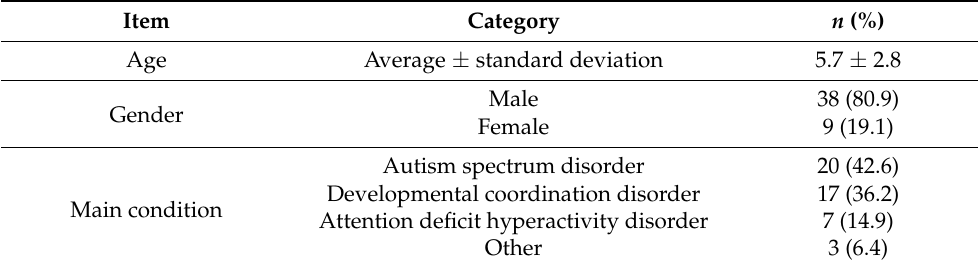
Table 1. Participants’ attributes and primary condition ( n =